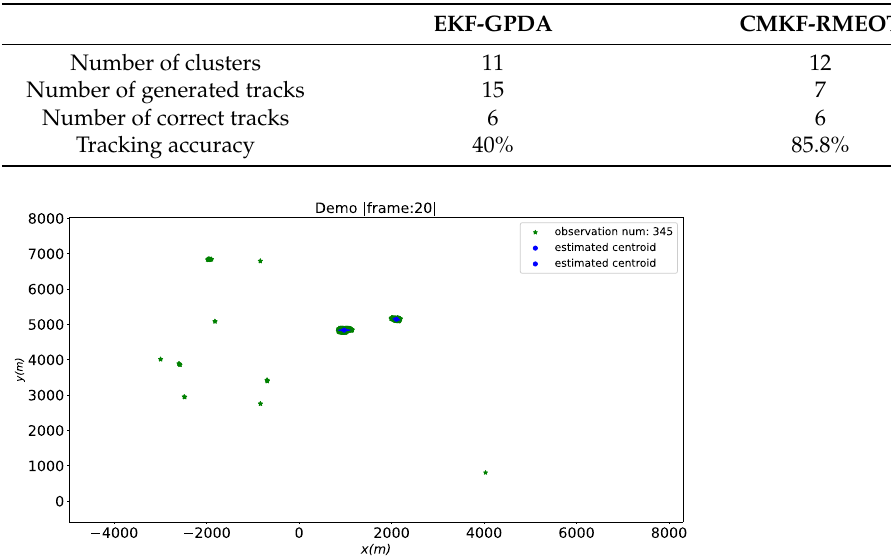
Figure 20. Multi-target tracking in the Cartesian coordinate system in the 20th frame.